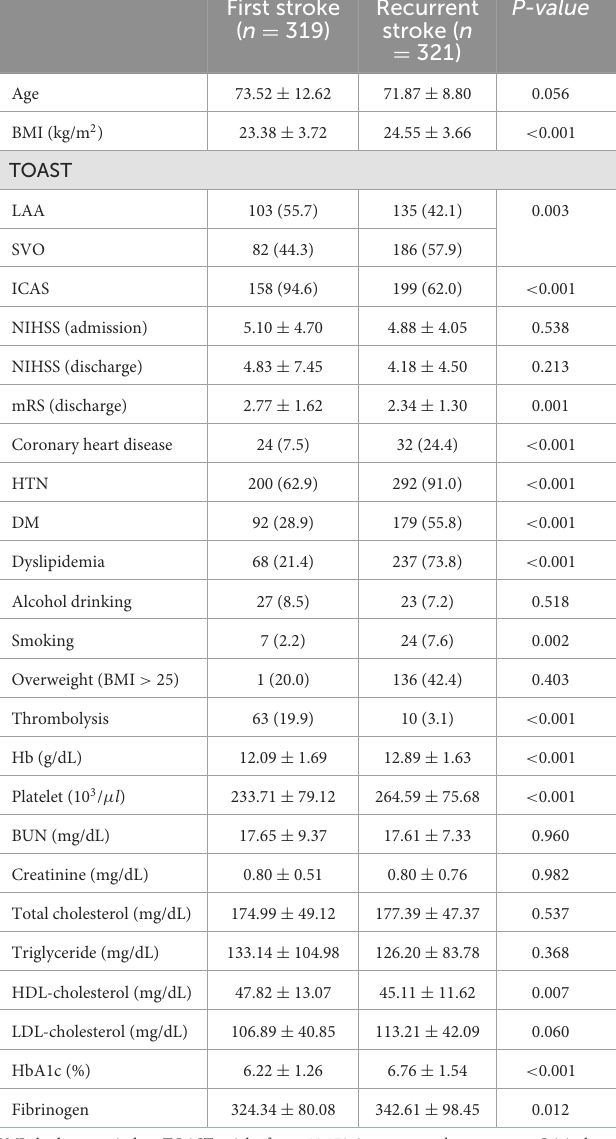
TABLE 3 Comparison of baseline characteristics between first ischemic stroke and recurrent ischemic stroke patients in female